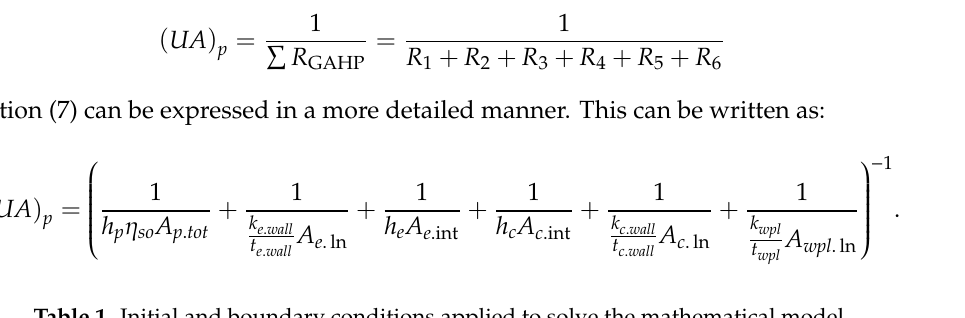
Table 1. Initial and boundary conditions applied to solve the mathematical